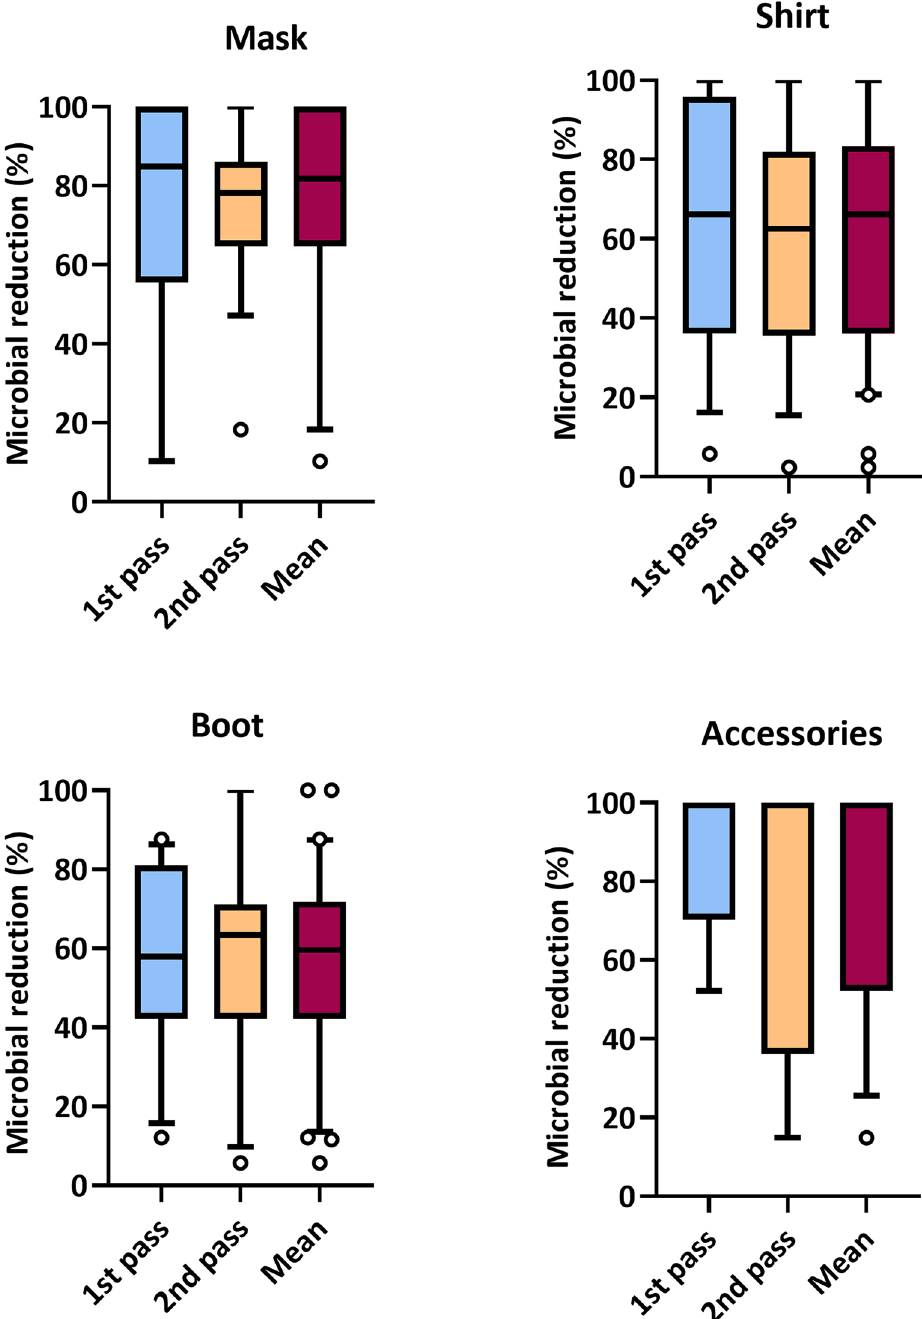
Figure 5. Comparison of the microbial reduction percentage (%) of different garments in two periods of the day. In the morning, before the start of the working day (1st pass) and in the afternoon, after the working day (2nd pass); with 30 s pass time in disinfection technology. Accessories comprise the following objects: helmets, hats, watches and glasses. Individual points plotted beyond the box-and-whisker plot indicate values that extend to the minimum and the